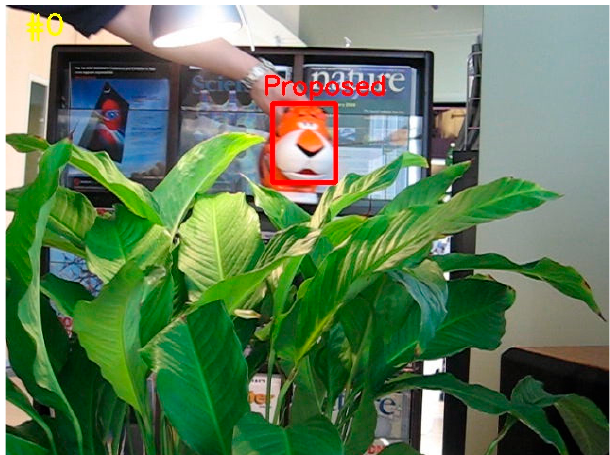
Figure 15. MB Attribute—First Frame of Tiger 1 Sequence.